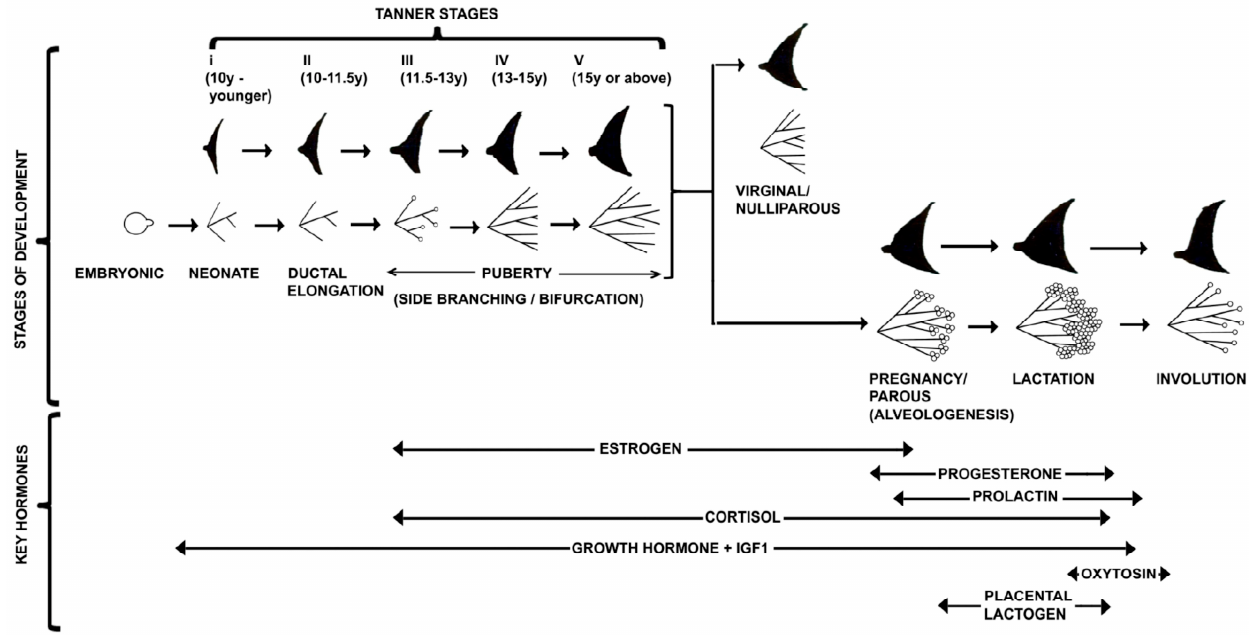
Figure 3. A schematic representation of different stages of mammary gland development connecting with embryonic mammary primordial, followed by the different postnatal stages along with key hormone dependent phases vs. independent phases, key transcription factors, and signaling molecules. The single circle represents terminal end buds (TEBs) during puberty, whereas multiple circles represent lubloalveolar units.